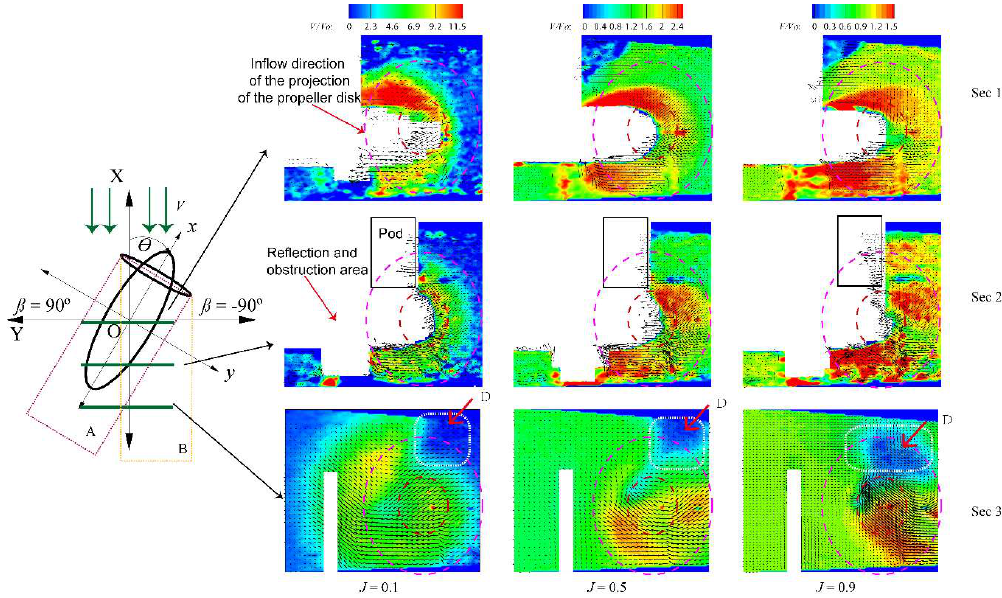
Figure 7. PIV measurements of the L-type podded propulsor in −30° oblique drive ( 𝐽 = 0.1, 0.5, and